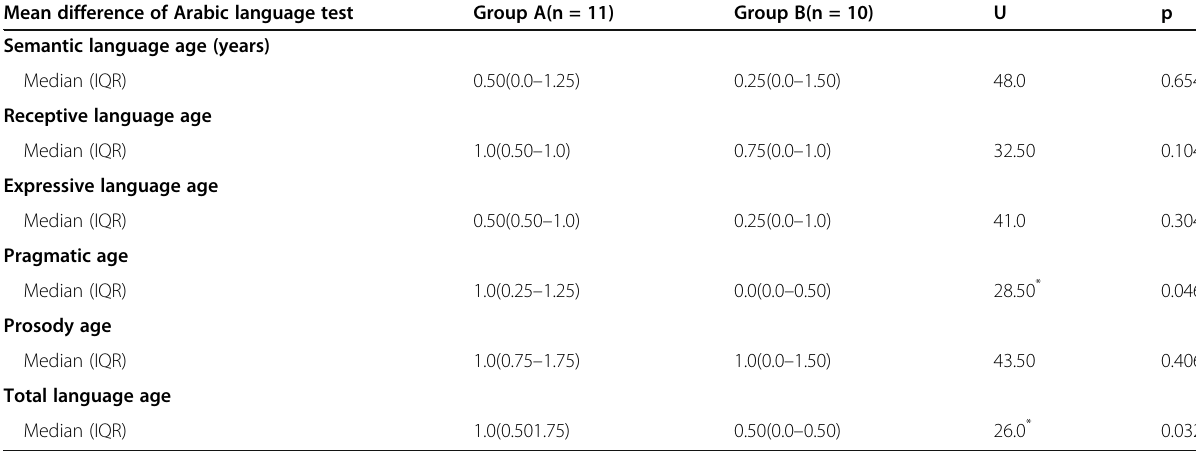
Table 3 Comparison between the two studied groups according to mean difference of Arabic language test